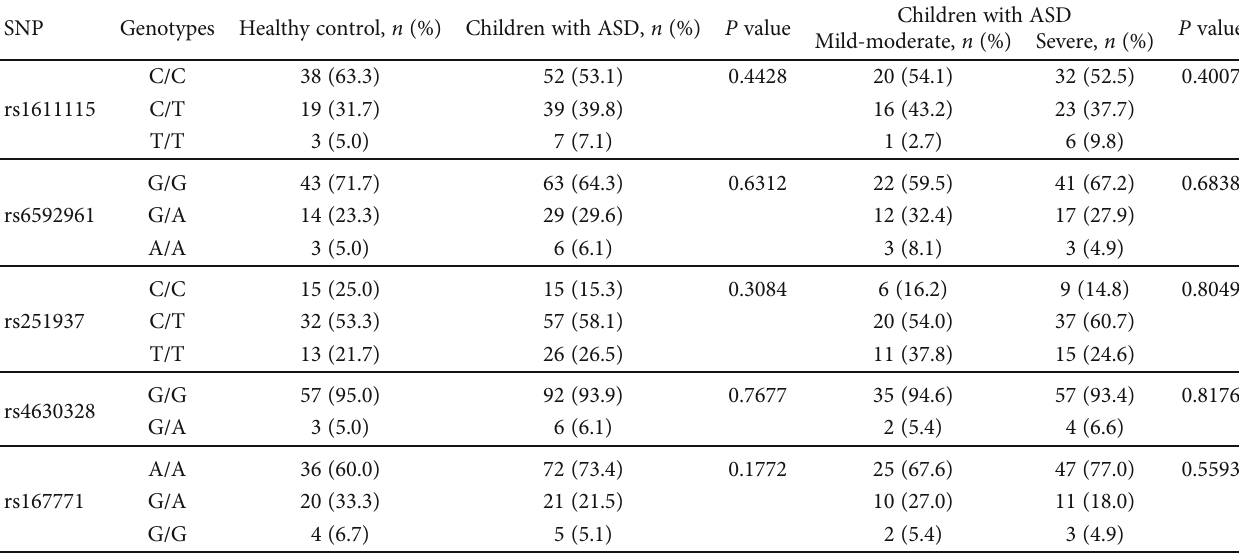
Table 3: Genotype frequencies of SNPs in children with ASD and in healthy